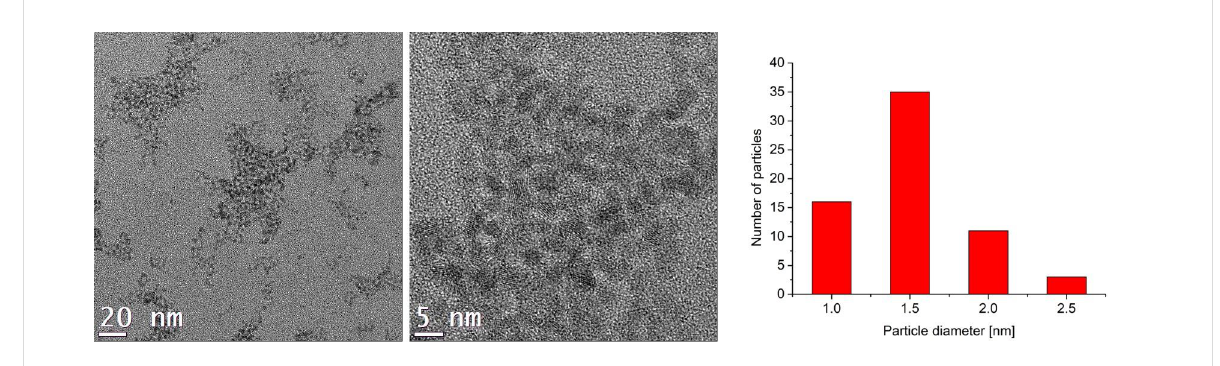
Figure 6: TEM images and particle size histogram of 1.0 wt % Gd-NPs in [BMIm][NTf 2 ] from Gd(amd) 3 .